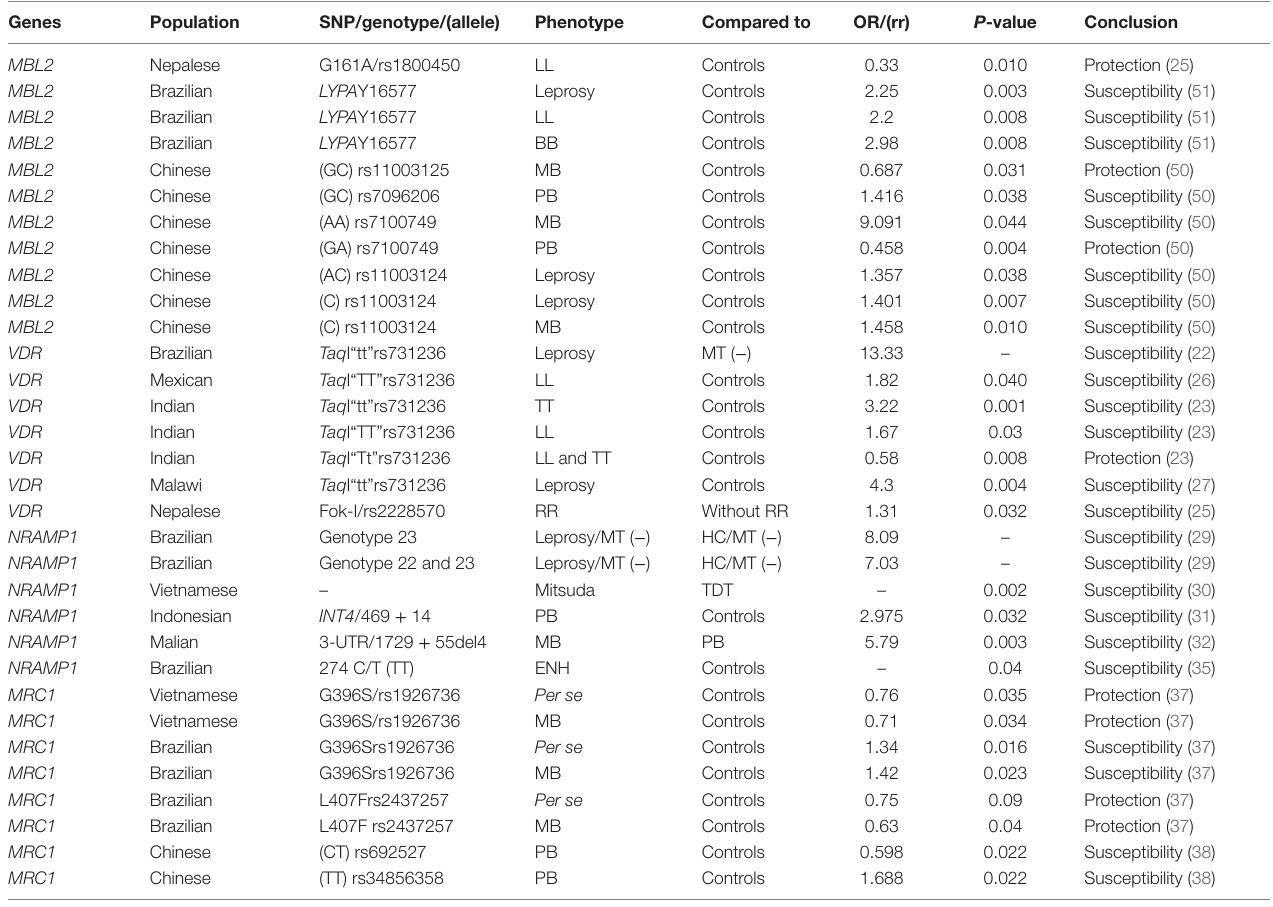
TABLe 2 | Summary of associations between genes of innate immune response MBL2 , VDR , NRAMP1 , MRC1 , and leprosy. Genes